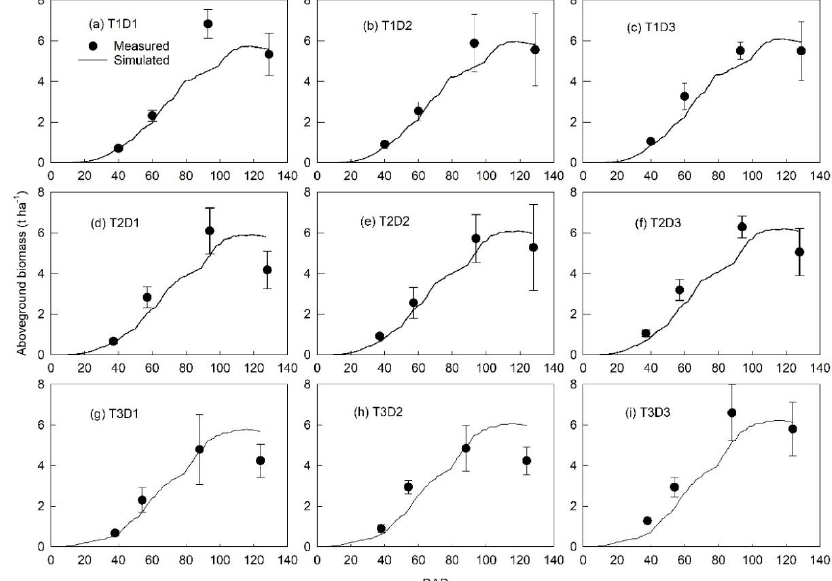
Figure 5. Simulated and measured leaf area index (LAI) of peanut under (a) T1D1, sowing on 25 April with 24 plants m −2 , (b) T1D2, sowing on 25 April with 30 plants m −2 , (c) T1D3, sowing on 25 April with 36 plants m −2 , (d) T2D1, sowing on 5 May with 24 plants m −2 , (e) T1D1, sowing on 5 May with 30 plants m −2 , (f) T1D1, sowing on 5 May with 36 plants m −2 , (g) T1D1, sowing on 15 May with 24 plants m −2 , (h) T1D1, sowing on 15 May with 30 plants m −2 , (i) T1D1, sowing on 15 May with 36 plants m −2 during 2017. Values are means of three replicates. DAP is the number of days after planting.